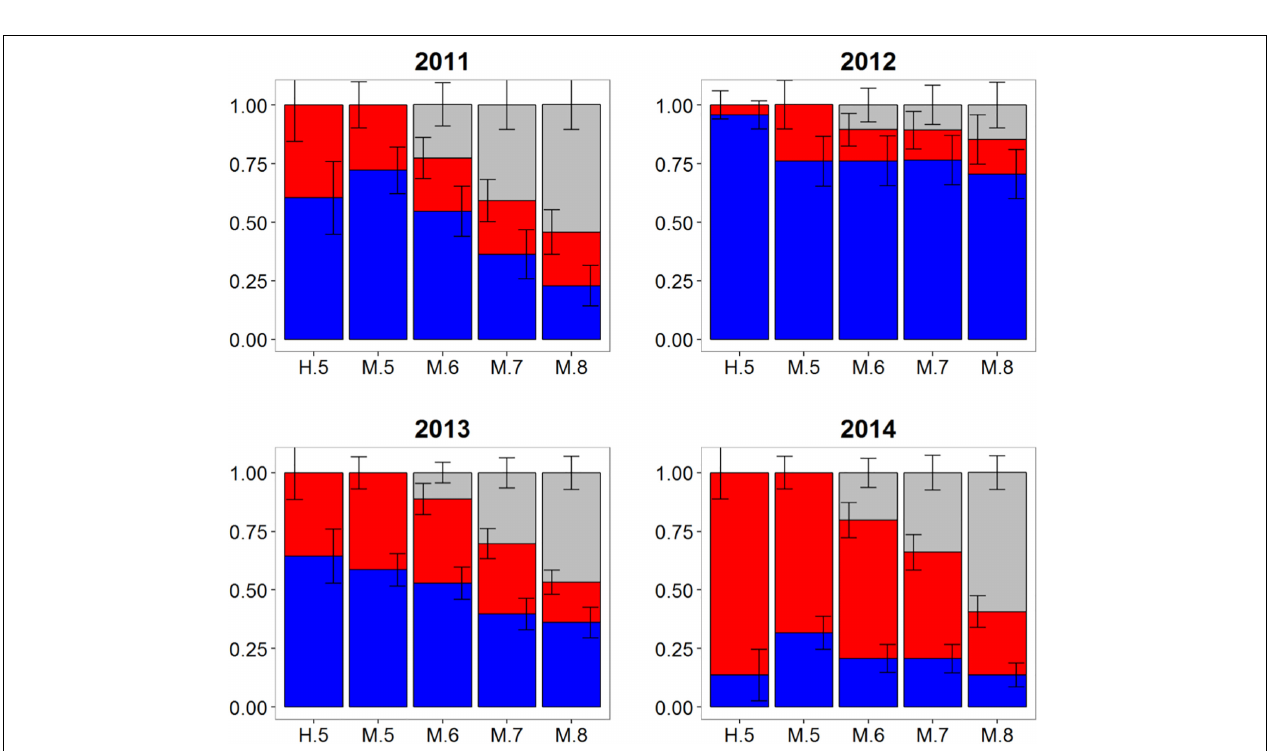
FIGURE 3 | Estimated proportions of western (blue), eastern (red), and undetermined (gray) Atlantic bluefin tuna in samples collected from 2011 to 2014 in the Central North Atlantic Ocean—West of 45 ◦ W. Results are based on mixed-population analysis using HISEA and multinomial logistic regression (MLR) frameworks. H.5 denotes predictions from HISEA while MLR estimates are shown as M.5, M.6, M.7, M.8 to represent the four different probability thresholds (0.5–0.8). Uncertainty around predictions shown with error bars which represent 1 ± SD around estimated proportion.